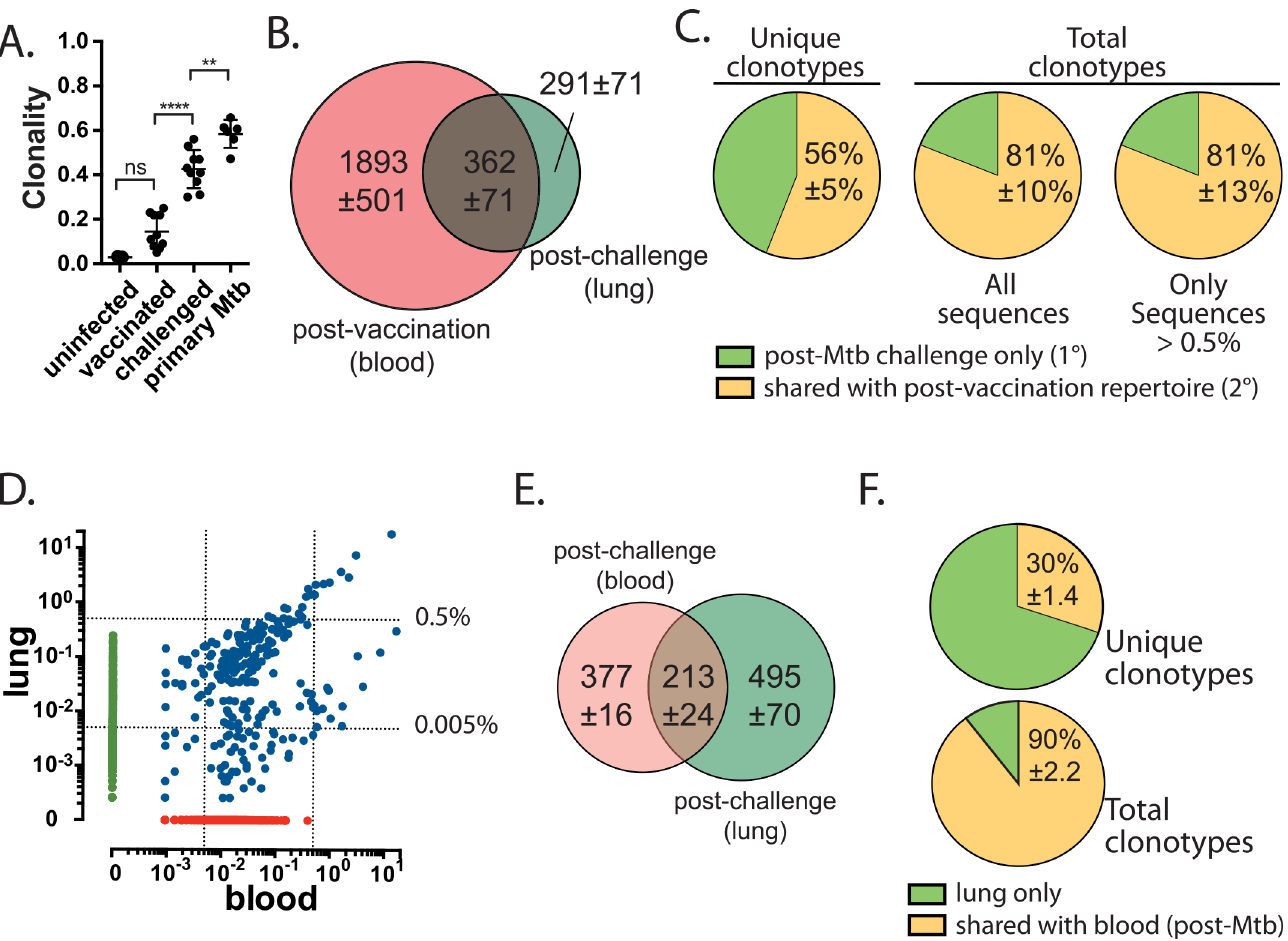
Fig 7. TCR β deep sequencing reveals the dual contribution of the primary and secondary effector CD8 + T cell response in vaccinated mice challenged with Mtb. (a) Clonality of TB10-specific CD8 + T cells from blood 1w after amphi-TB10 vaccination, compared to those isolated from lung in the same individuals 4-5w after Mtb challenge, or compared to those isolated from unvaccinated, Mtb-infected mice [data for primary Mtb-infected mice from [32]]. Data are from 3 – 10 individuals/group, independently analyzed from two independent experiments. One-way ANOVA with a Bonferroni post-test was used to compare clonality. * p < 0.05, **** p < 0.0001. (b) Sharing of unique TCR β DNA sequences between the post-vaccination (blood) and post-Mtb challenge (lung) repertoires of TB10-specific CD8 + T cells. Numbers are the average of unique TCR β DNA clonotypes, determined for four subjects, each analyzed individually. (c) The percentage of the lung TB10-specific CD8 + TCRs detected either only post-Mtb challenge (e.g., 1° response); or, detected both post-vaccination and post-Mtb challenge (e.g., 2° response). Left, unique clonotypes; center, total TCRs; right, total TCRs that had a frequency of > 0.5%. (d) Representative logarithmic scatter plot showing the frequencies of all clonotypes detected in the blood or in the lung of a single individual 5 weeks after Mtb challenge. Green, lung only; Red, blood only; Blue, Shared. The dotted lines indicate frequencies of 0.005% and 0.5%, respectively. (e) Sharing of unique TCR β DNA sequences between blood and lung repertoires of TB10-specific CD8 + T cells in individual mice, 5 weeks after infection. Numbers are the average of unique TCR β DNA clonotypes, determined for three subjects analyzed individually. (f) The percentage of the lung repertoire of TB10-specific CD8 + TCRs that were detected only in the lung ( “ lung only ” ) or detected in the blood and lung ( “ shared with blood ” ) after Mtb challenge. Left, unique clonotypes; right, total TCRs. Only clonotypes with a frequency of > 0.005% were